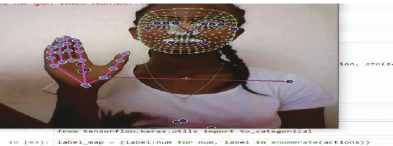
Figure 15: An image for a real-time detection feeding.